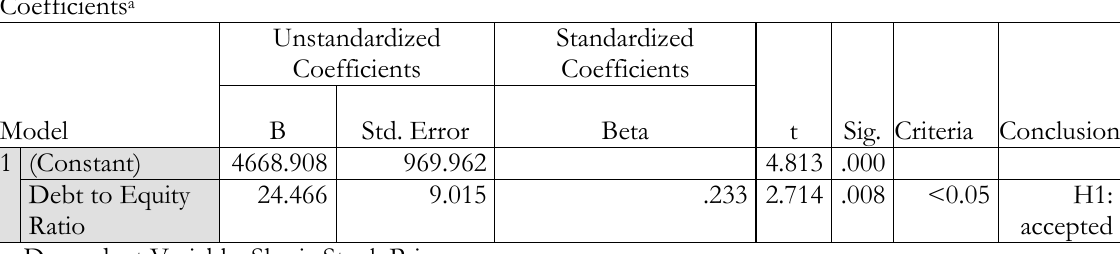
Table 1 Partial Regression